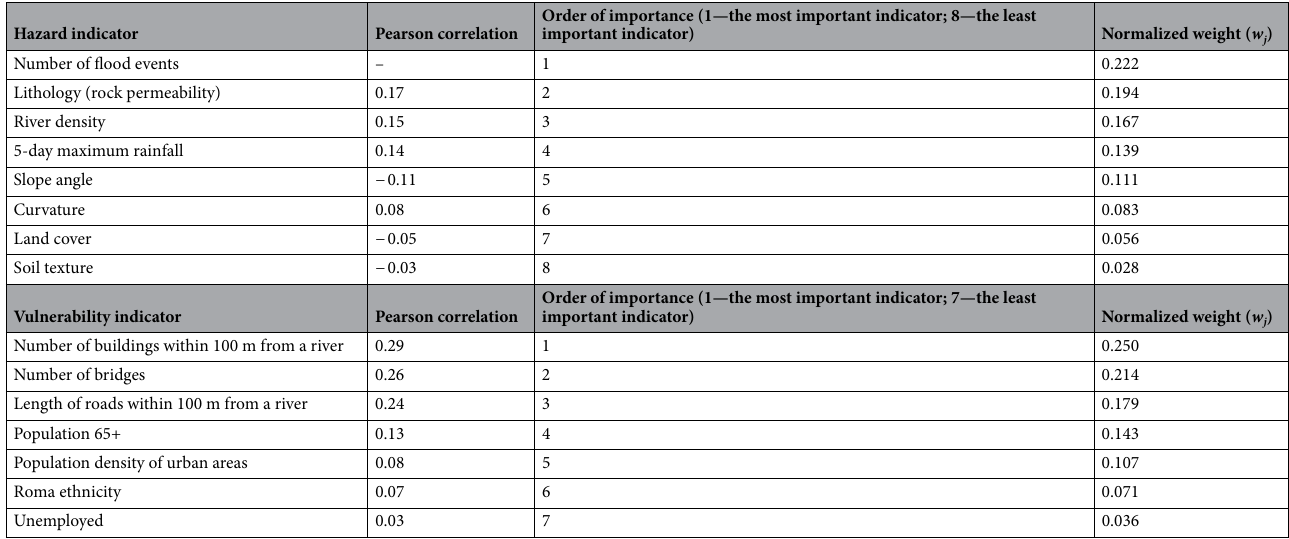
Table 1. Correlation between indicators and the number of flood events and normalized weights of